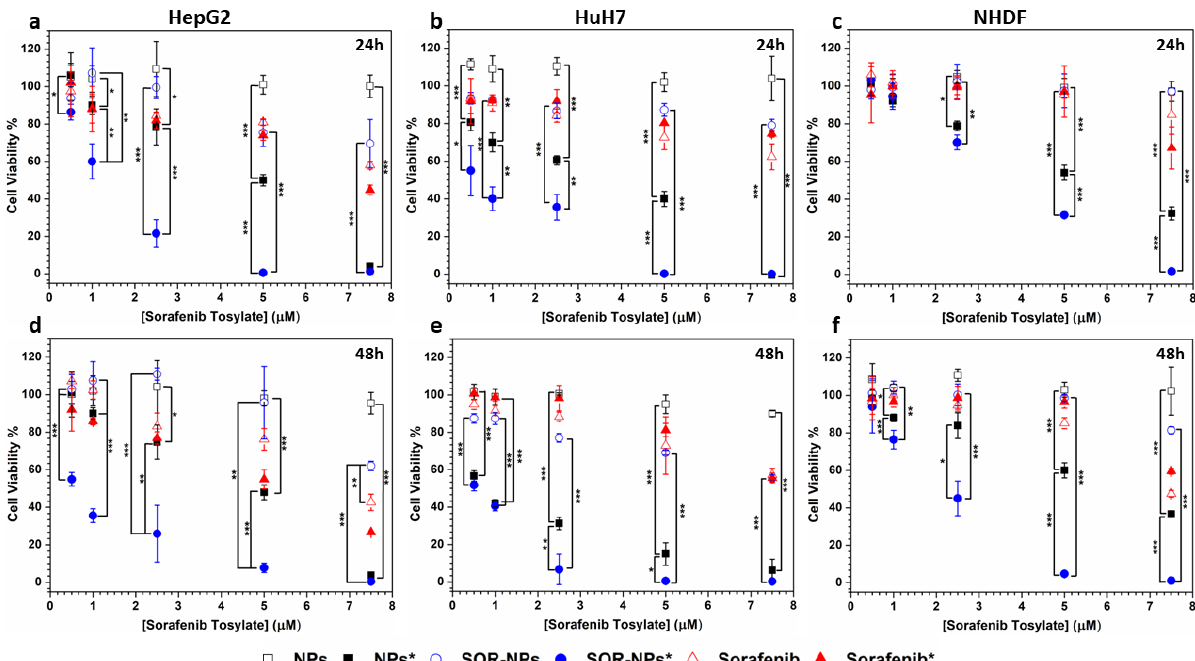
Figure 9. SOR-NPs dual-mode cytotoxicity studies on HepG2 (panel ( a , d )), HuH7 (panel ( b , e )) and NHDF (panel ( c , f )) after 24 h (panel ( a – c )) and 48 h (panel ( d – f )) of incubation with different samples (*: NIR laser treated) (* p < 0.05, ** p < 0.01, *** p < 0.005).